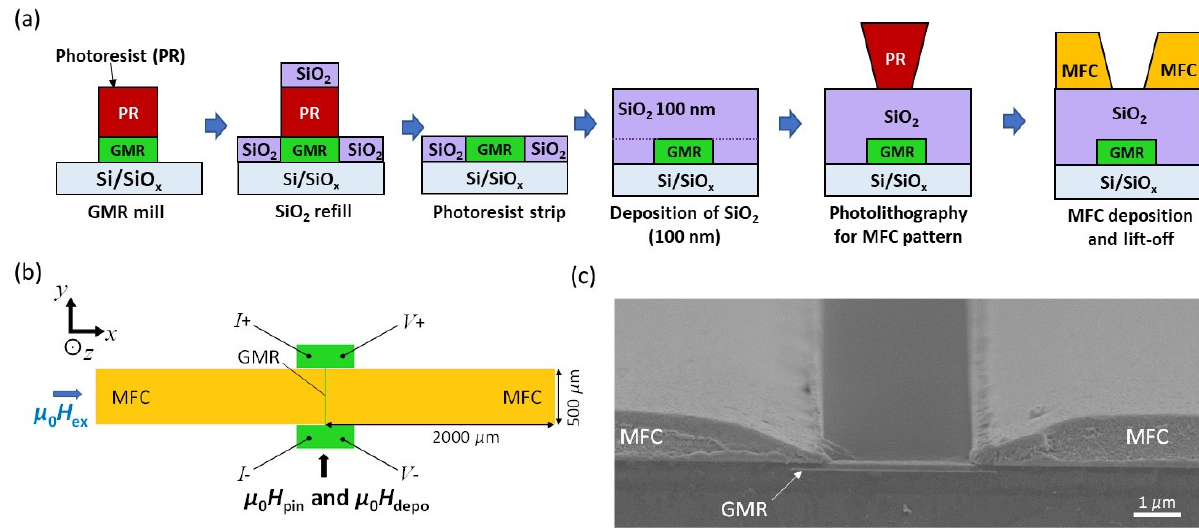
Figure 4. ( a ) Fabrication process flow of the GMR sensors with MFCs. ( b ) Schematic plan view and ( c ) cross-sectional SEM image of the GMR sensors. ( c ) cross-sectional SEM image of the GMR